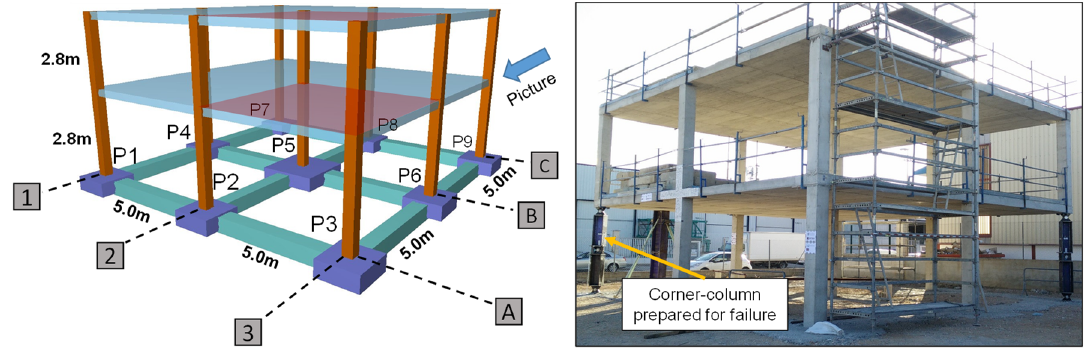
Figure 1. Sketch and photograph of the building prepared for the sudden corner-column removal.